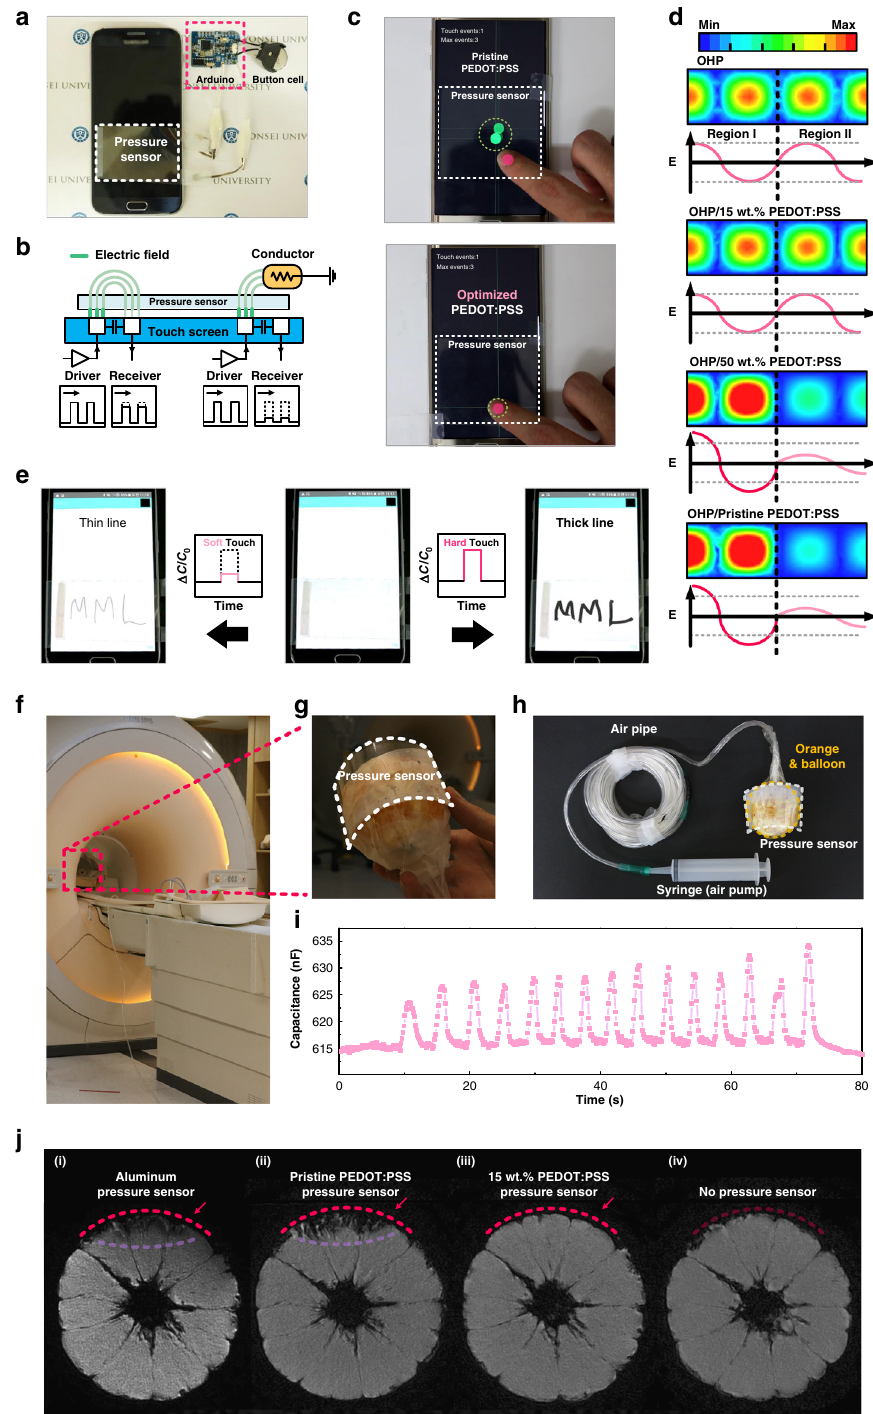
Fig. 5 Demonstration of general applicability of pressure sensors. a Pressure sensor connected to Arduino board with Bluetooth module. b Schematic of electric fi eld distribution when a transparent capacitive pressure sensor using 15 wt.% poly(3,4-ethylenedioxythiophene):-poly(styrenesulfonate) (PEDOT: PSS) is directly attached to a touch device, together with the difference between the ‘ untouched ’ and ‘ touched ’ states. c Touch accuracy of touchscreen connected to pressure sensors with pristine PEDOT:PSS and 15 wt.% PEDOT:PSS fi lm. The red dot indicates the position of at which the sensor is actually touched, while the green dot indicates the spot where touch device recognizes the touch. d The three-dimensional (3D) electromagnetic (EM) simulation of 100 MHz electromagnetic wave propagation in waveguide through PEDOT:PSS fi lms of different concentrations. e Demonstrated writing application in which the thickness of a letter can be adjusted by varying the applied pressure. f Photograph of the setup of the magnetic resonance imaging (MRI)- compatible pressure sensor. An arti fi cial beating orange is being scanned by MRI. g Photograph of a MHz-transparent pressure sensor attached to an arti fi cial beating orange. h Setup for arti fi cial beating orange. A syringe is used to control the size of the balloon inside the orange. i Changes in capacitance due to the arti fi cial beats measured by the MRI-compatible pressure sensor during MRI scanning. j MR images of orange with a pressure sensor consisting of aluminum, pristine PEDOT:PSS, 15 wt.% PEDOT:PSS electrodes, and without a pressure